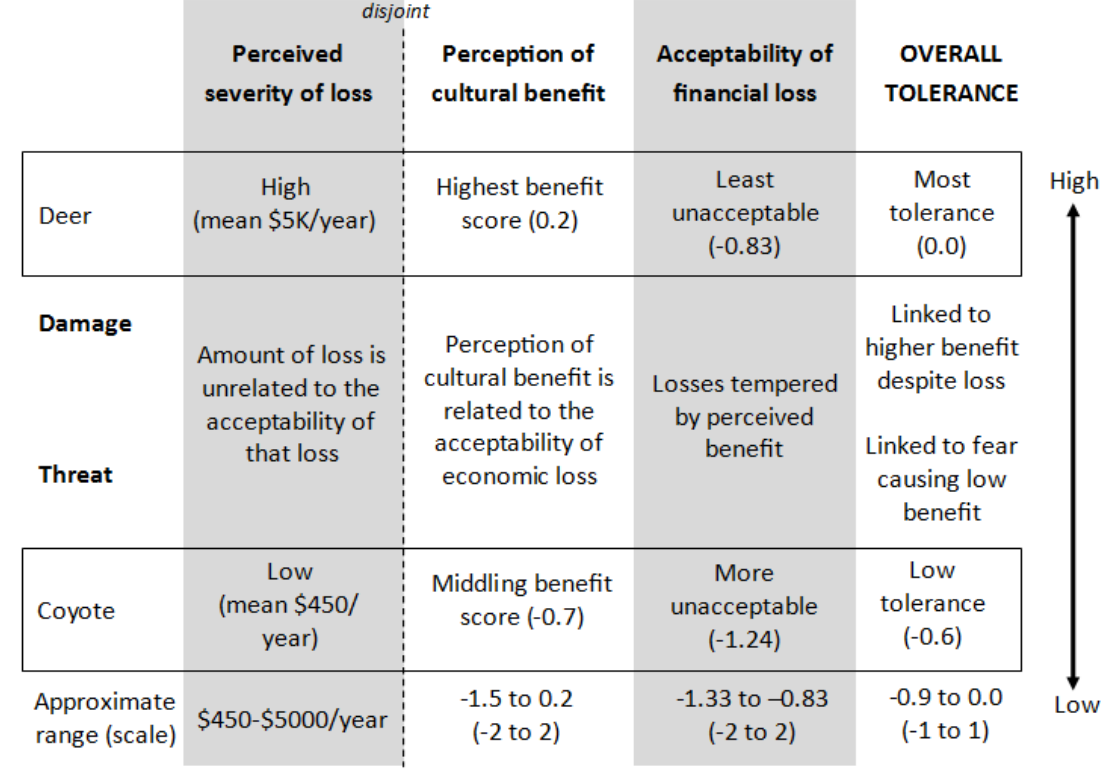
Figure 2. Theoretical drivers of species tolerance by nuisance type, using